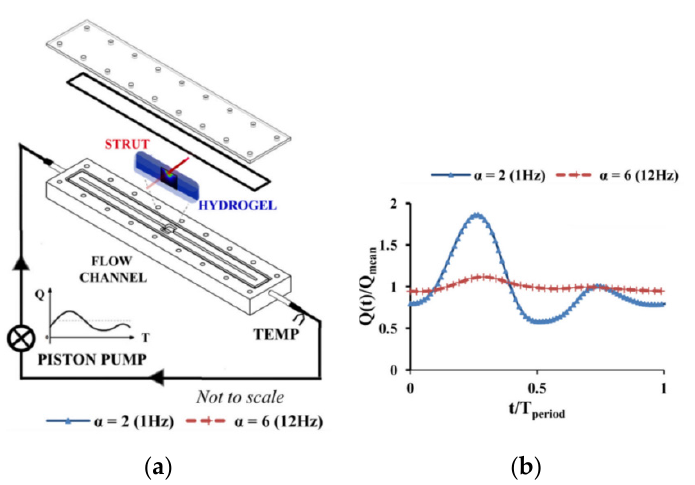
Figure 10. (a) Experimental test bench, ( b ) pulsatile and steady inlet flow rate waveforms used in this study, reprinted from [42]